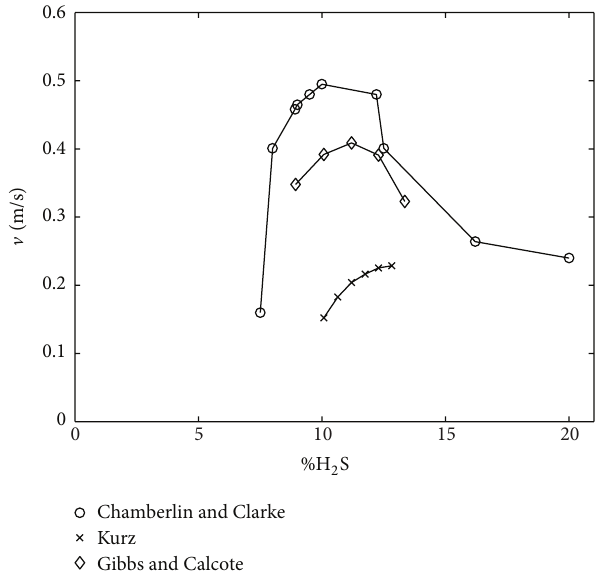
Figure 2: Flame speed of H 2 S-air mixtures at different concentra-